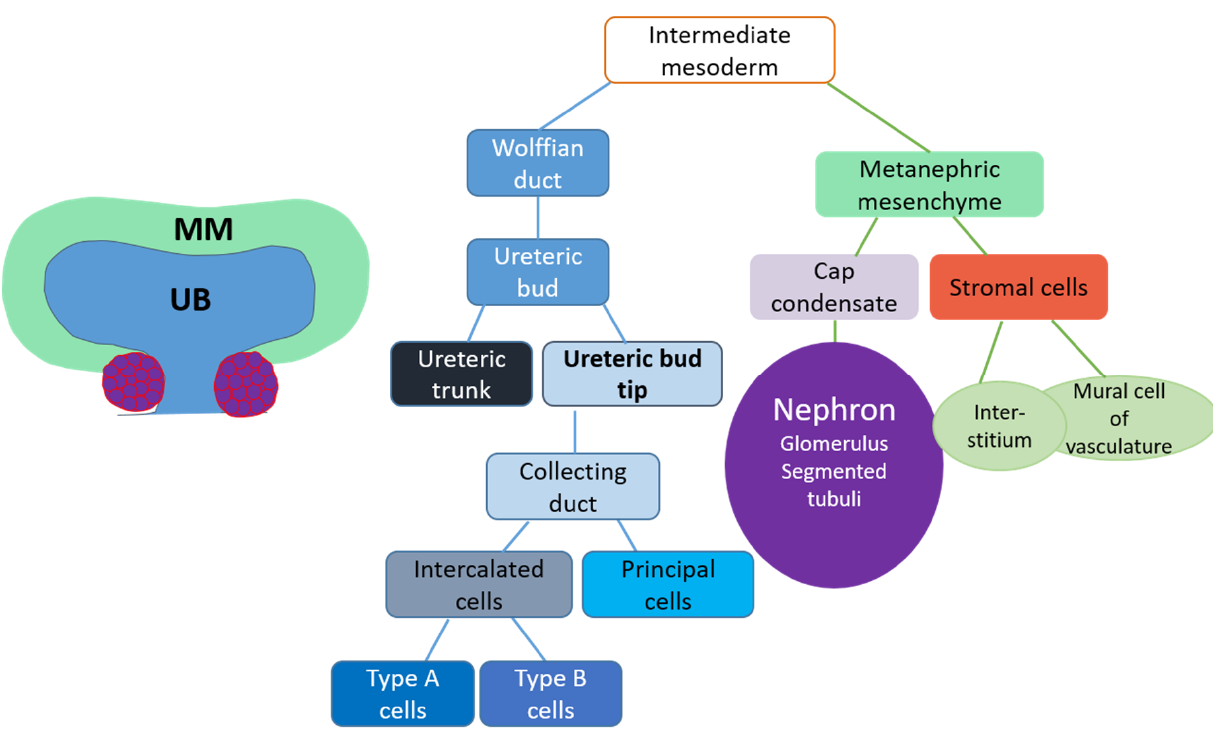
Figure 2. The illustration of kidney lineages and their origins. The left illustration shows a schematic presentation of an embryonic kidney with the bifurcated ureteric bud (UB, blue), which is derived from epithelial conversion of the intermediate mesoderm called the Wolffian duct. As illustrated in the middle scheme, the ureteric bud is subdivided into trunk and tip regions, where tips represent undifferentiated cells and trunks are occupied by differentiation-committed cells. Upon epithelium maturation, collecting ductal cells differentiate into specialized intercalated and principal cell types. Metanephric mesenchyme (MM, green), which surrounds the epithelial UB, lineages are depicted on the right. Metanephric mesenchyme is composed of cap condensate mesenchyme, which contains nephron progenitors, and stromal cells. The nephron progenitors in the cap condensate undergo mesenchyme-to-epithelium transition to initiate differentiation of all the segments of nephron (glomerulus and segmented tubuli) in the armpits of UB. The stromal cells of MM differentiate into renal stroma